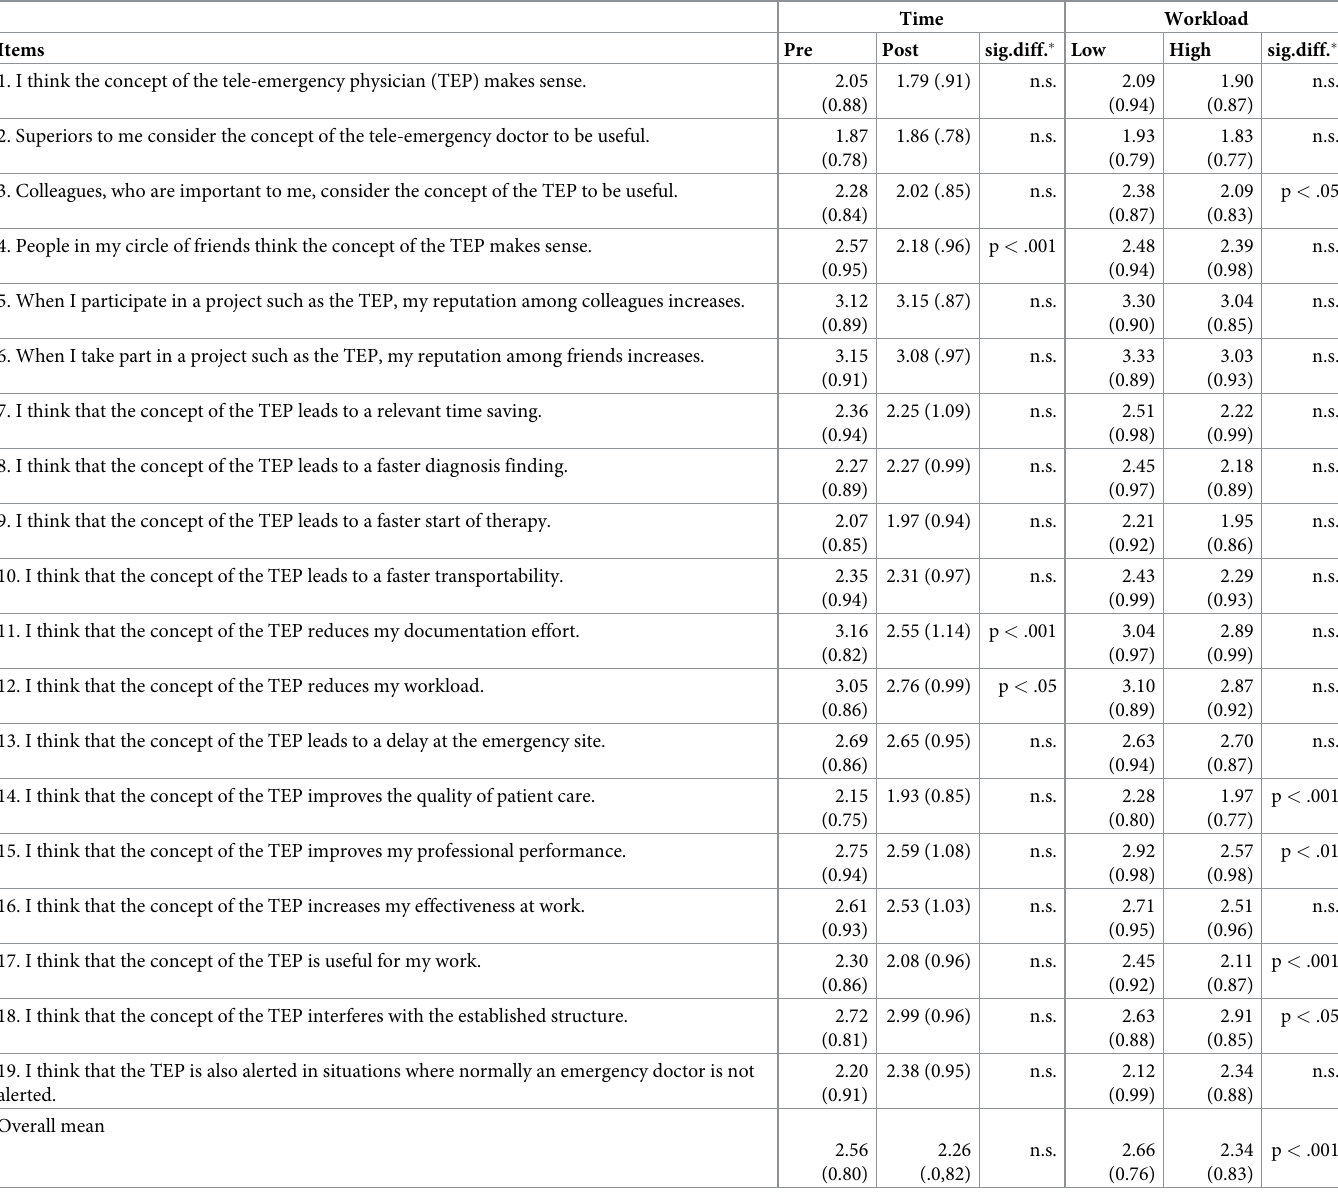
Table 5. Items concerning acceptance of the TEP system with means (and standard deviations) as a function of time (pre, post) and workload (low, high).